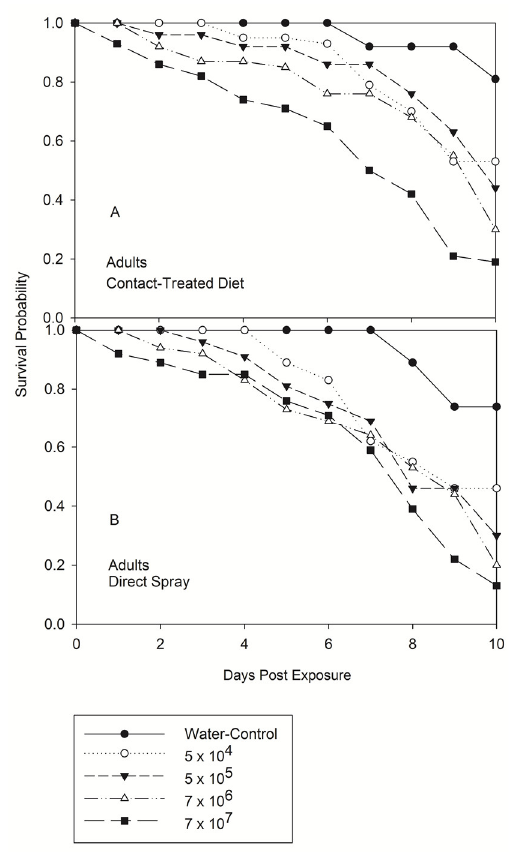
Figure 3. Product-limit survival estimates for adults of Nezara viridula exposed by contact (treated diet) ( A ) and direct spray ( B ) to Beauveria bassiana , Delta native NI8 strain at different concentrations. Insects were fed with an artificial diet ( p = 0.05, LIFETEST of Equality over Strata).